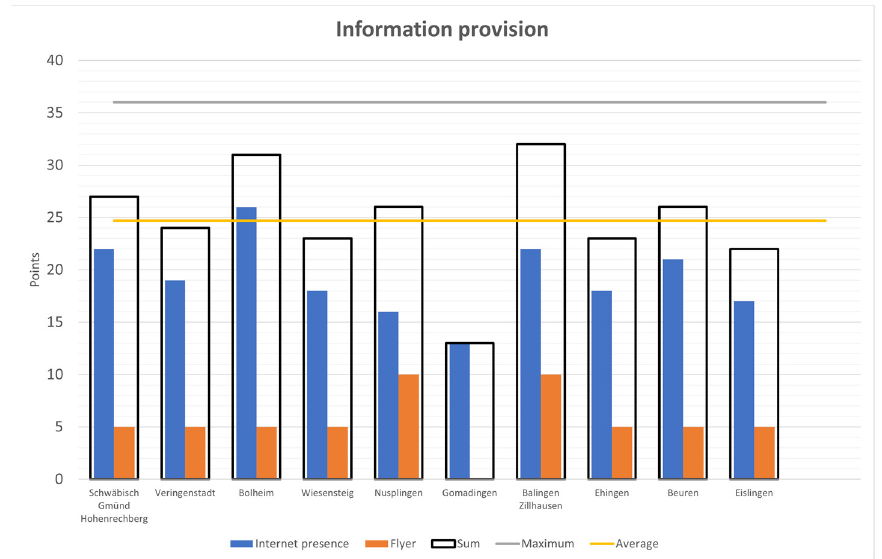
Figure 21. Information provision (Julian Stolz 2022).